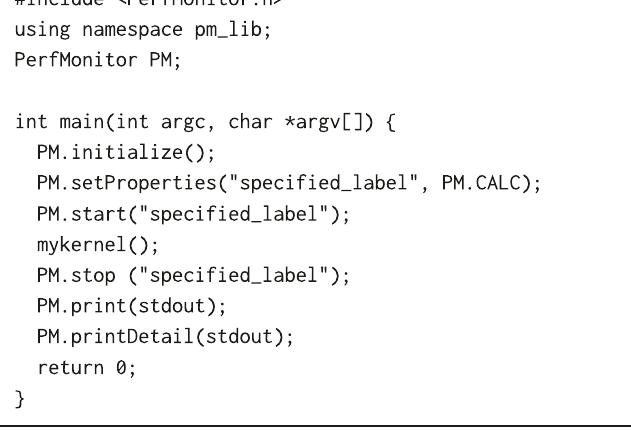
Figure 8: Example of instrumentation using PMlib .